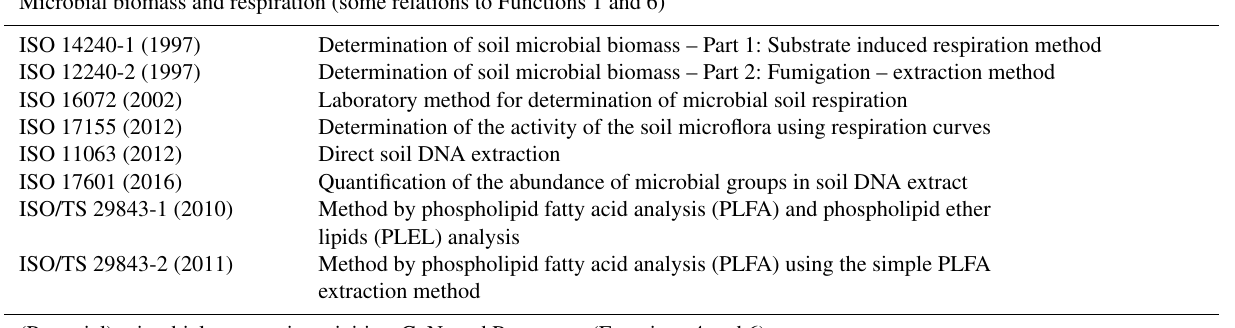
Table 2. Methods already validated and published as ISO standards for determining potential microbial biomass and activities for soil quality. Microbial biomass and respiration (some relations to Functions 1 and